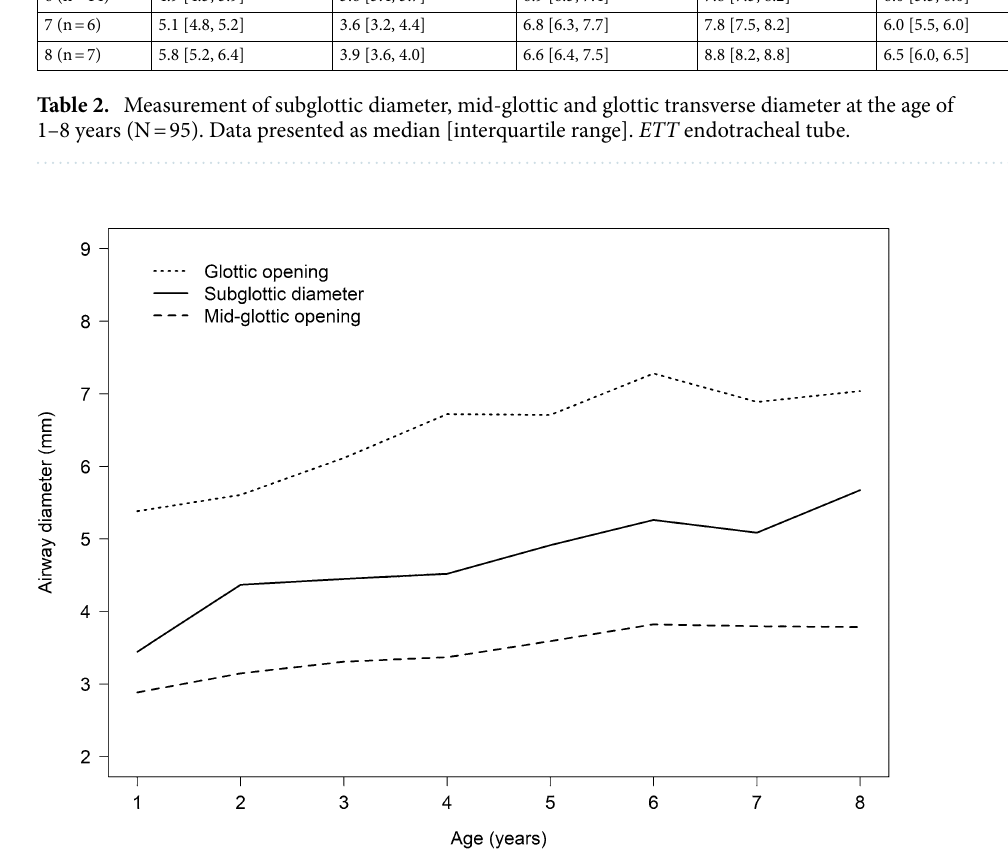
Figure 3. Relationship between airway ultrasound diameter and age.